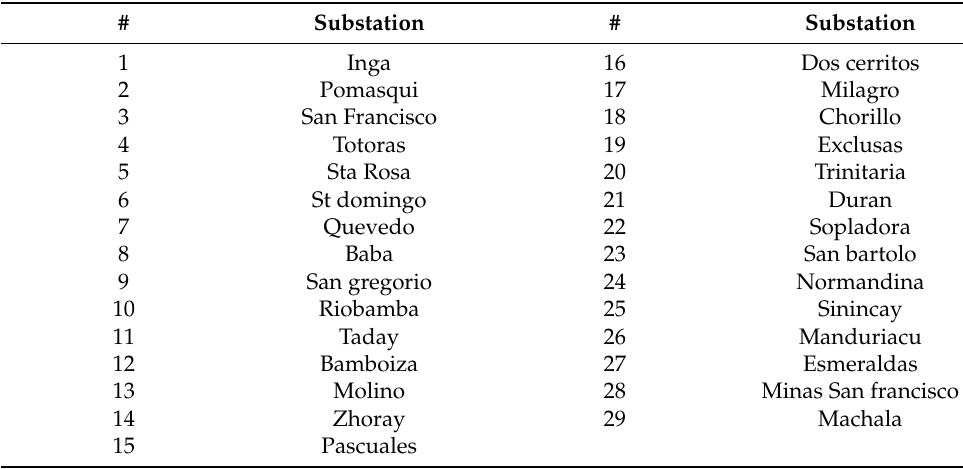
Figure 3. Ecuador electric system: 230 kV. Table 1. Substation name with its reference